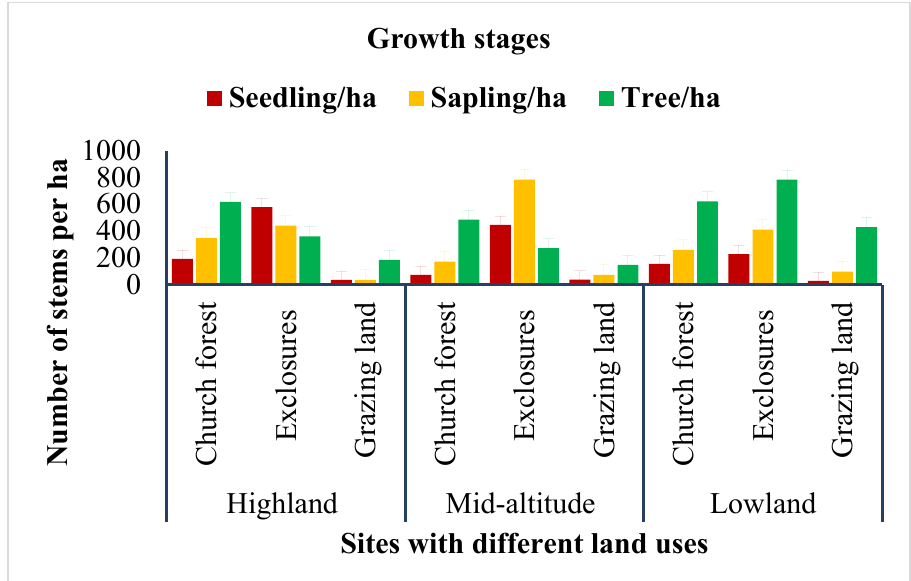
Figure 5. Regeneration status of woody species across different land uses. At churches, the upper canopy affects the regeneration, so the population is only competent trees. It is an indicator of an unbalanced community. Junipers procera and Olea european are dominant species in most church forests in the highlands of Ethiopia. How- ever, there is low regeneration because of the low open space and high trampling effect of livestock. This idea is similar to that of [39], who found that in highland parts of North Wollo, Junipers procera and Olea european are common dominant species having J-shaped structures. There are only big trees in dense forest, and there are low seedling and sapling populations. In exclosures, the population structure is an inverted J-shape structure, which means there is a high population of seedlings and saplings. This is an indicator of